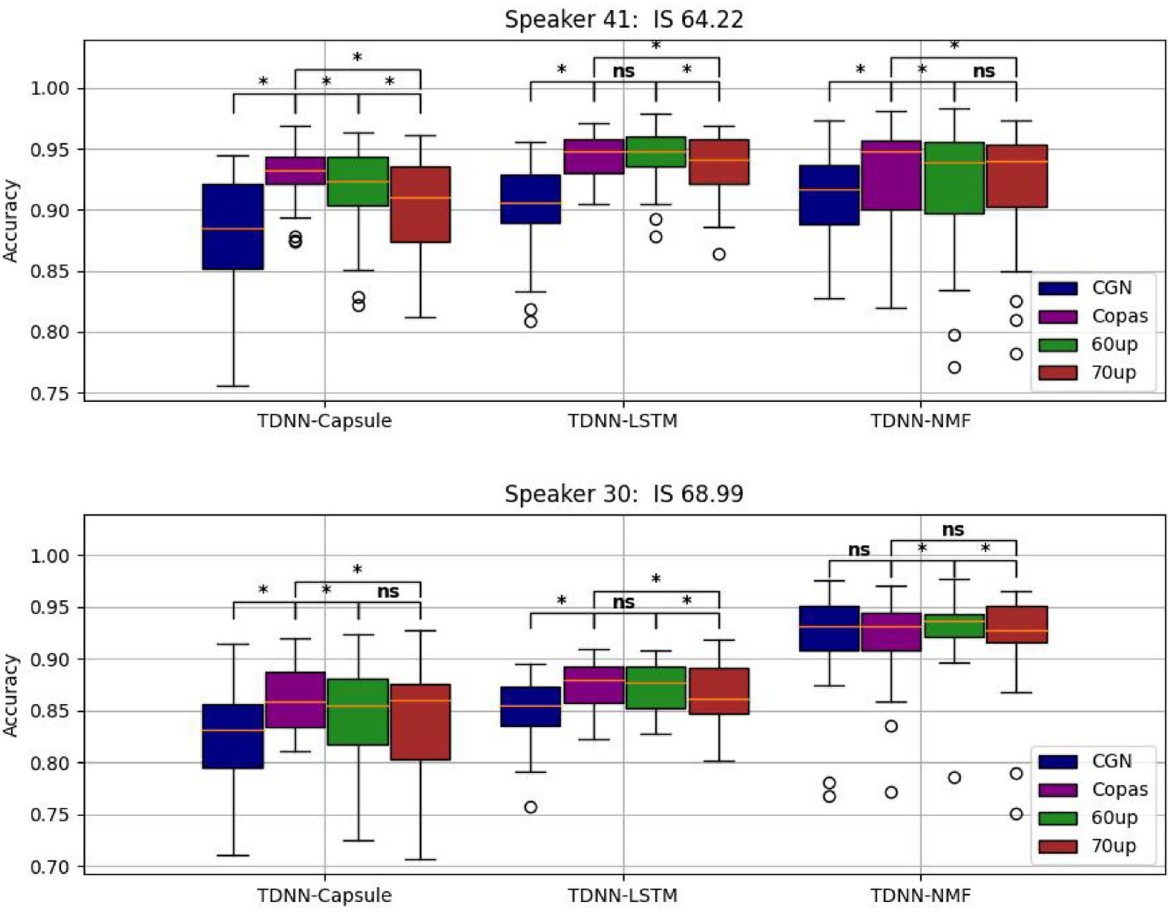
Fig. 12 Performance of the TDNN acoustic models combined with the capsule network, LSTM, and NMF decoder for SLU with insufficient task-specific training data for the speaker 41 and the speaker